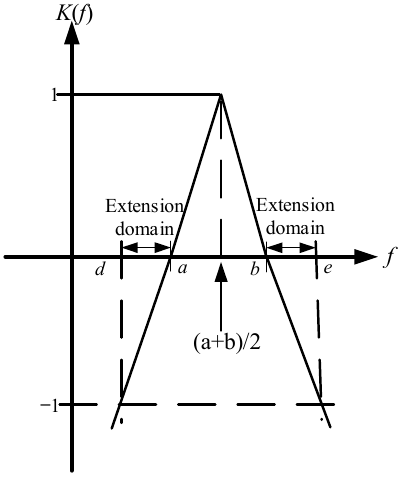
Figure 8. Schematic of the elementary correlation function.